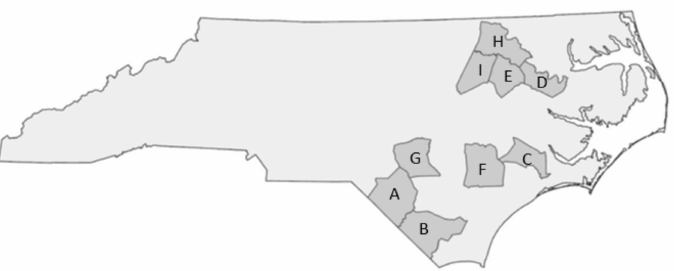
Figure 4. Locations of nine counties assessed as a potential study area: Robeson County (A); Colum- bus County (B); Jones County (C); Martin County (D); Edgecombe County (E); Duplin County (F); Cumberland County (G); Halifax County (H); and Nash County (I).